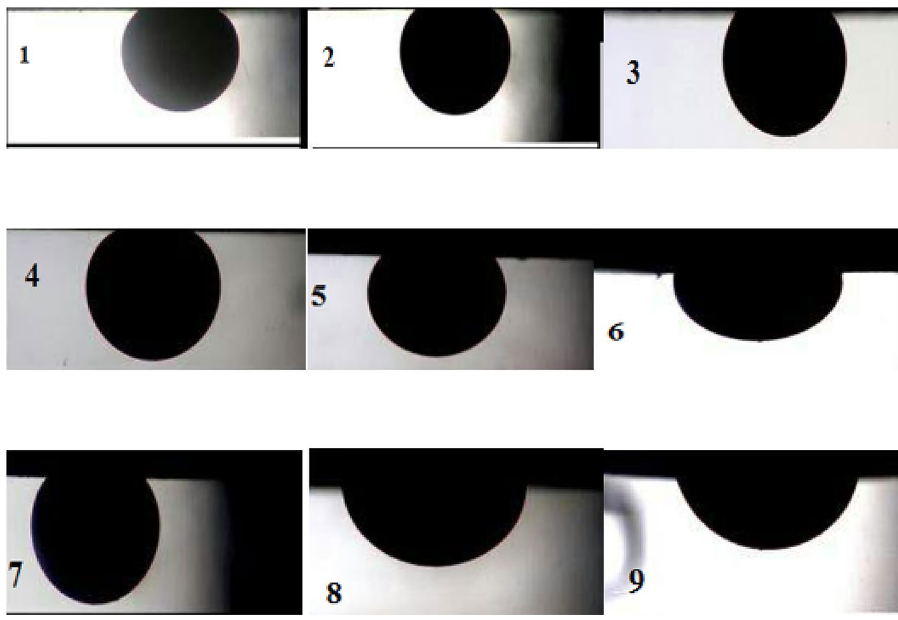
Fig. 12 Oil drop images stick- ing onto the carbonate cross section in contact angle